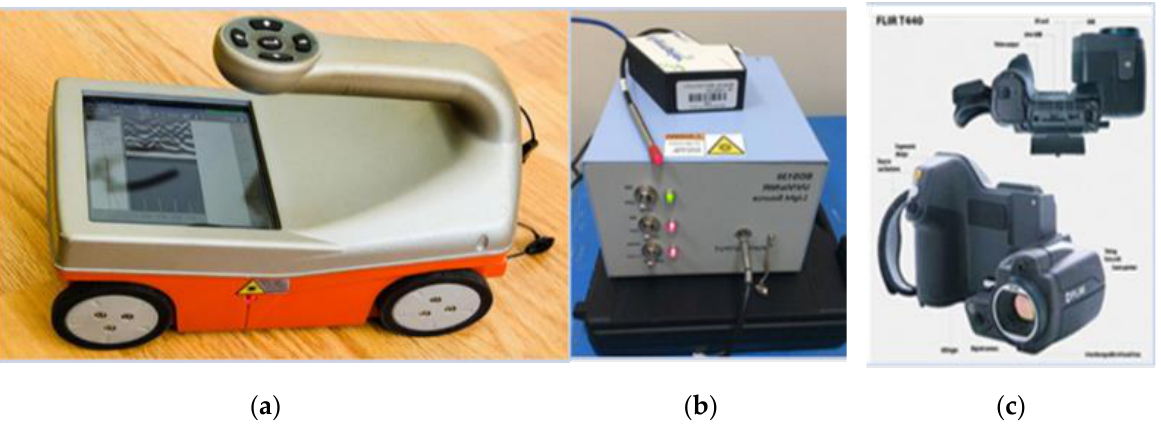
Figure 7. ( a ) GPR; ( b ) Exemplar LS Spectrometer; and ( c ) FLIR T420.